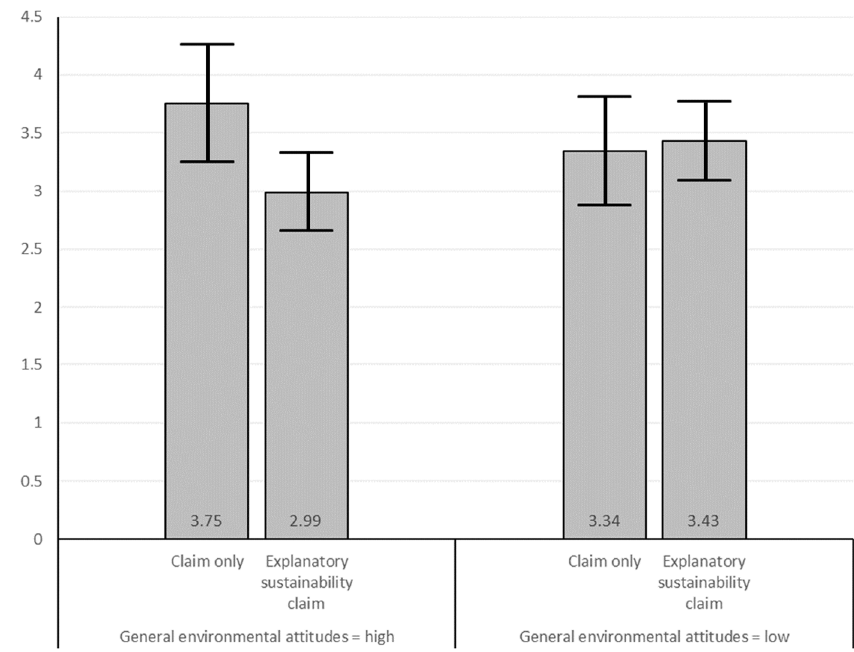
Figure 4. Model implied means of green skepticism with 95% confidence intervals.